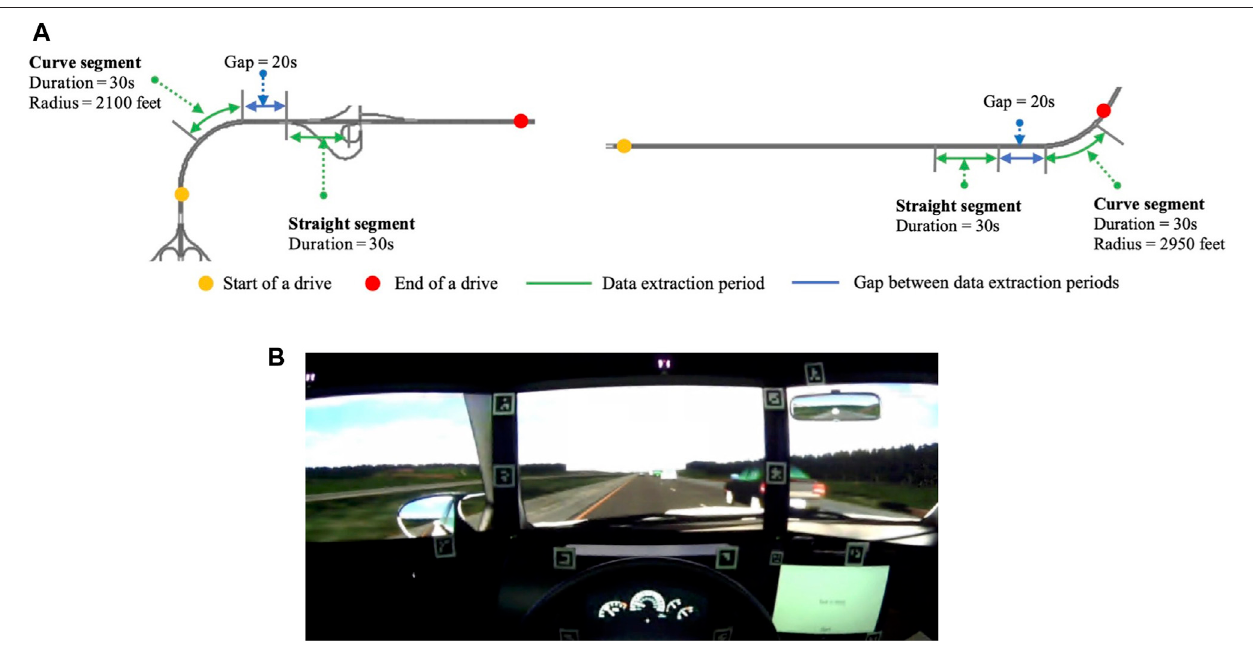
FIGURE 2 | Data extraction period of highway drives (A) , and picture of the simulated environment on highway (B) .